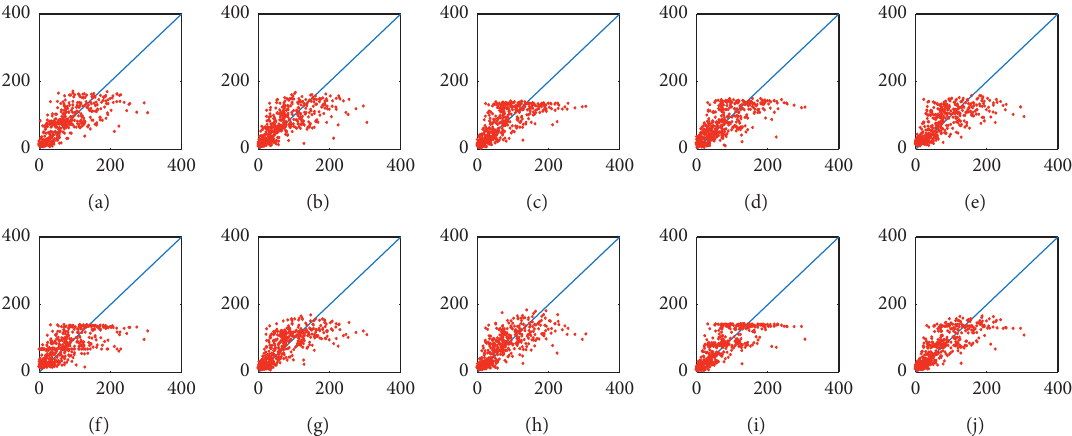
Figure 8: Scatter plots between downscaled results and observed precipitation in the period of 1961–2005 for MLP. Horizontal axes show observed precipitation, and vertical axes show the MLP results. (a) AC10, (b) AC13, (c) GG, (d) GH, (e) GM, (f) GR, (g) IN, (h) Nor, (i) MME, (j) BMA.